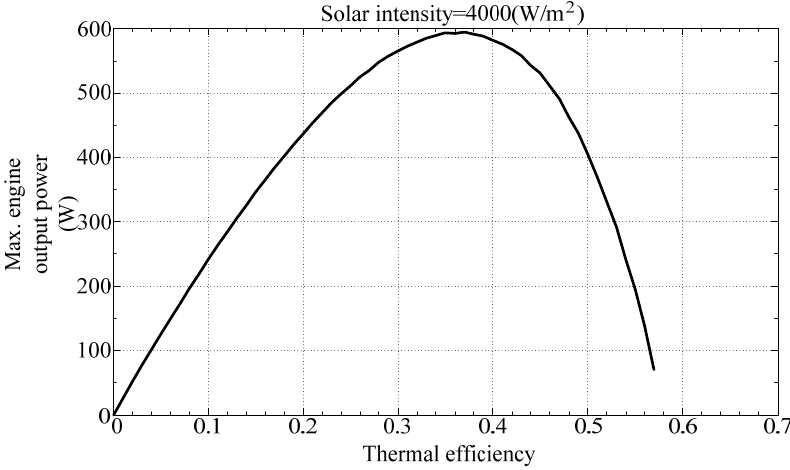
Figure 6. Maximum engine output power with respect to thermal efficiency.